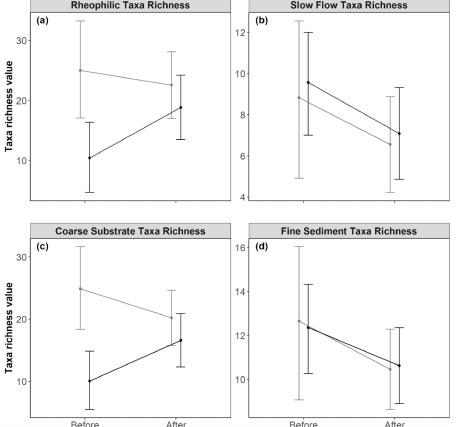
Figure 6. Linear model outputs (mean and 95% confidence intervals) indicating the effects of restoration on the richness of taxa preferring different flow velocity or sedimentological conditions. Control = grey; restored = black. ( a ) Rheophilic, ( b ) slow flow taxa, ( c ) coarse substrate taxa and ( d ) fine sediment taxa